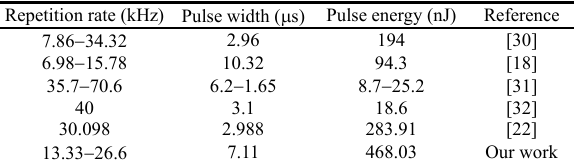
Table 1 Typical Q-switched fiber lasers based on